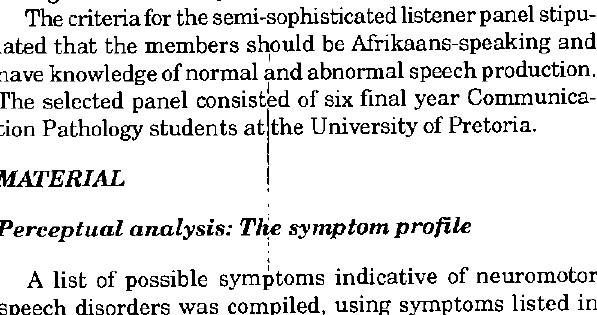
TABLE 1: Nonsense units slotted into sound structure and articulation characteristics SOUND